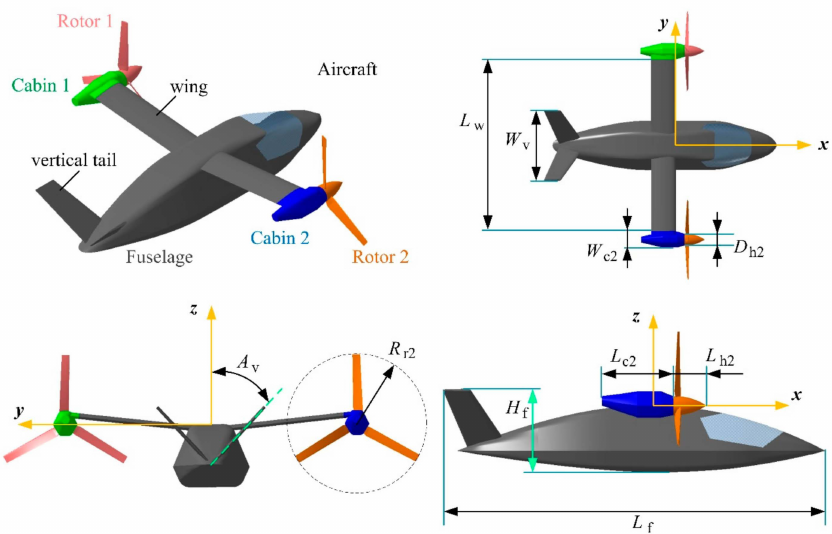
Figure 3. Model of the tiltrotor